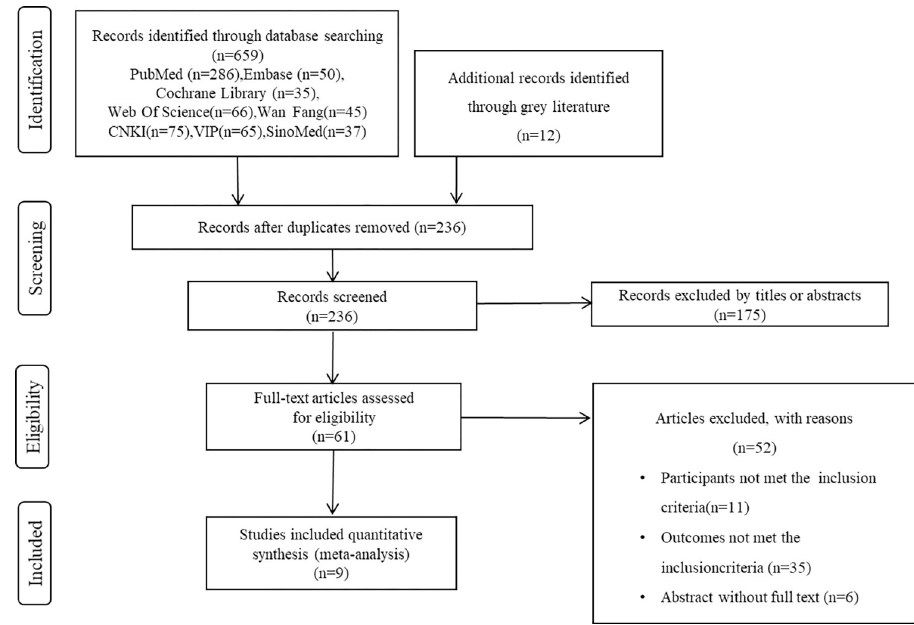
Fig 1. Flowchart of the literature search and screening process.